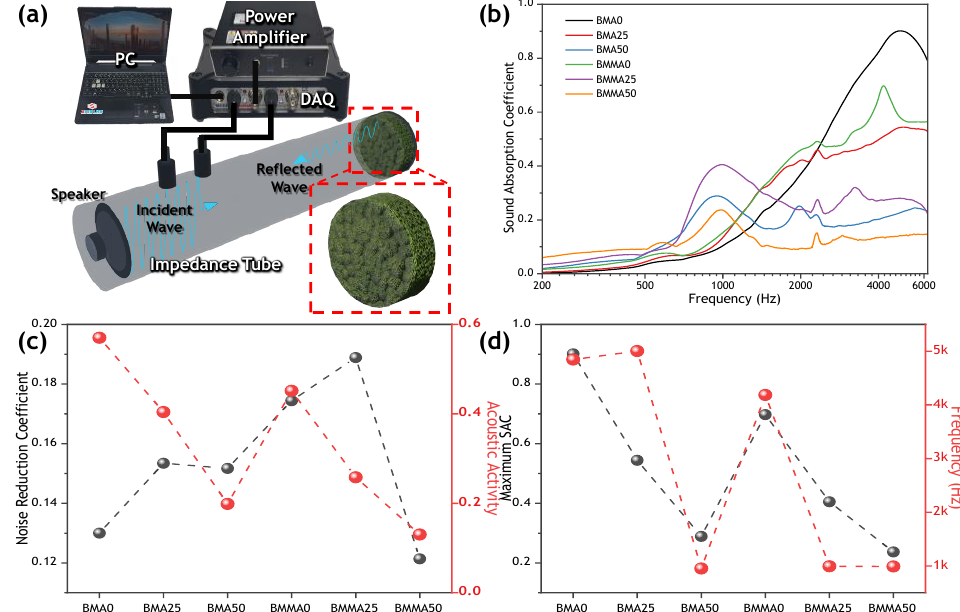
Figure 3. Results of sound-absorption performance. ( a ) Schematic of sound-absorption coefficient (SAC) measurement using an impedance tube. ( b ) Sound-absorption coefficient of the samples. ( c ) Noise-reduction coefficient and acoustic activity of our samples. ( d ) Maximum SAC values and resonant frequencies for each